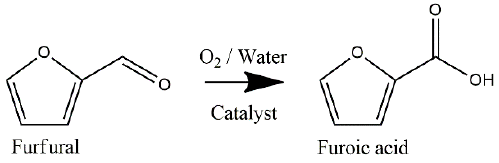
Scheme 1. Reaction scheme of the catalytic oxidation of furfural to furoic